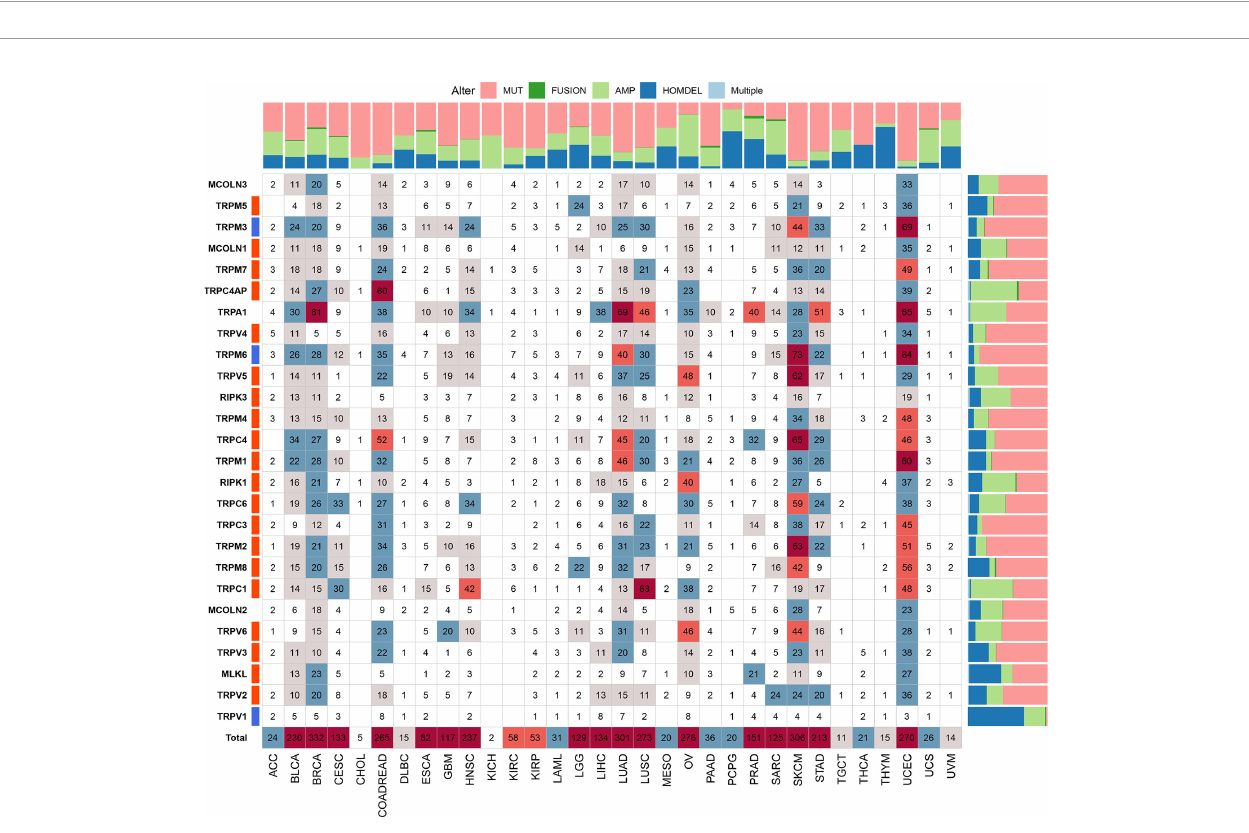
FIGURE 3 | The genetic alteration numbers of TRP family genes. The genetic alteration numbers of TRP family genes in each tumour type. The number represents the occurrence of mutations, fusions, ampli fi cations, homozygous deletions, or multiple alterations per